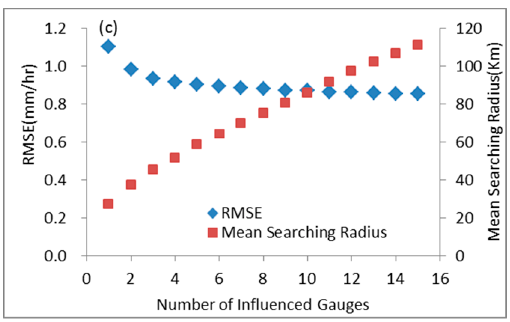
Figure 6. Curves for RMSE and the number of influence gauges with the increasing number of gauges over Reg. I ( a ), II ( b ) and III ( c ), respectively, in China.